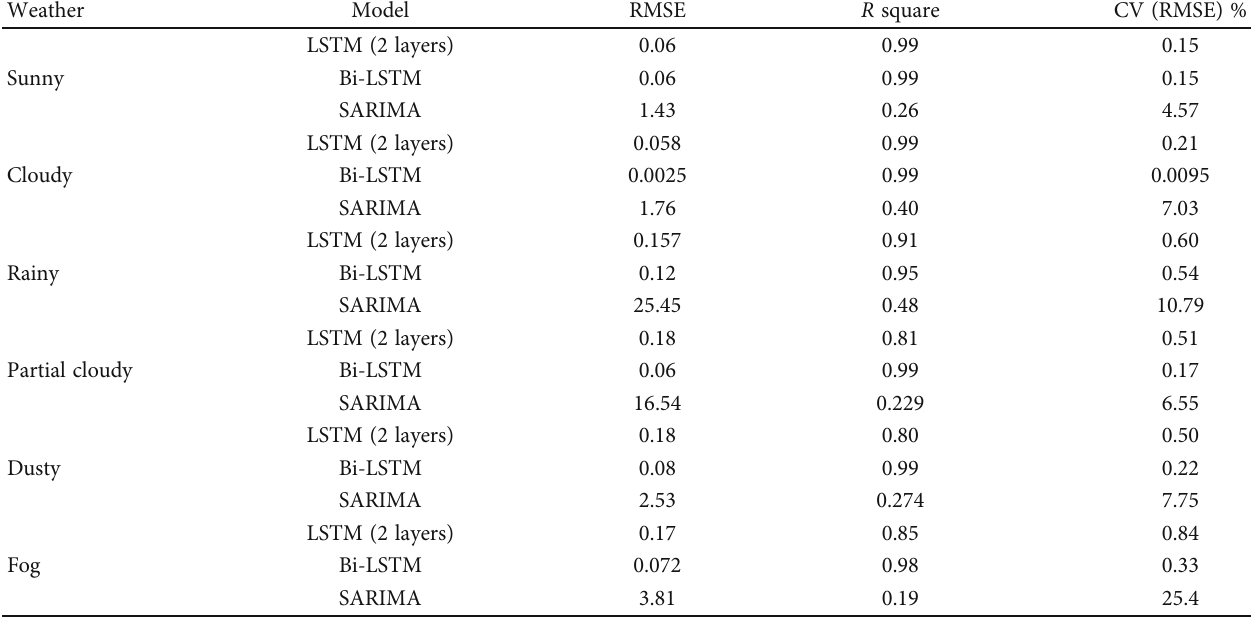
Table 5: Results of LSTM, Bi-LSTM, and